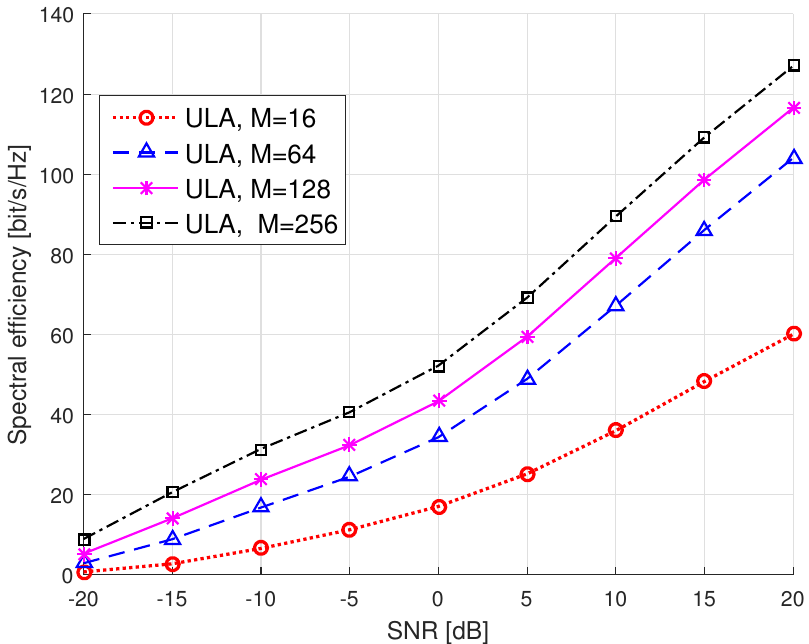
Figure 8. Spectral efficiency vs. SNR in dB for the ULA topology, U = 10 UEs, α A ( AS ) = 5, with different numbers of base station